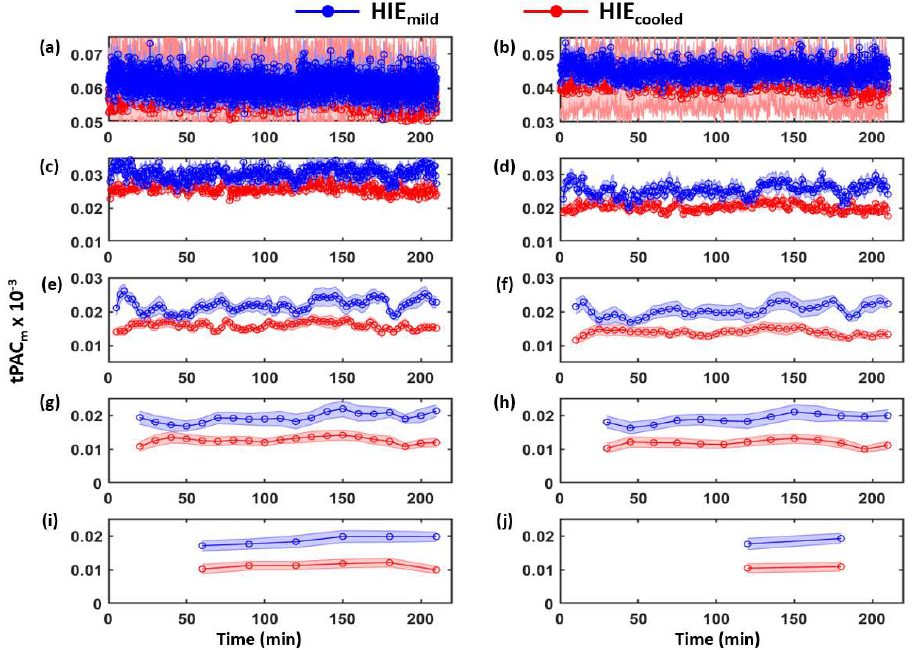
Figure A5. tPAC m indexes at Fz from HIE mild (blue) and HIE cooled (red) under ( a ) 10 s; ( b ) 20 s; ( c ) 1 min; ( d ) 2 min; ( e ) 5 min; ( f ) 10 min; ( g ) 20 min; ( h ) 30 min; ( i ) 60 min; ( j ) 120 min window sizes. Each point denotes the cross-neonate average of tPAC m for the group at different time in the 6 HOL. The shaded error bar indicates the standard error of the mean. t = 0 indicates the start of EEG re- cording.